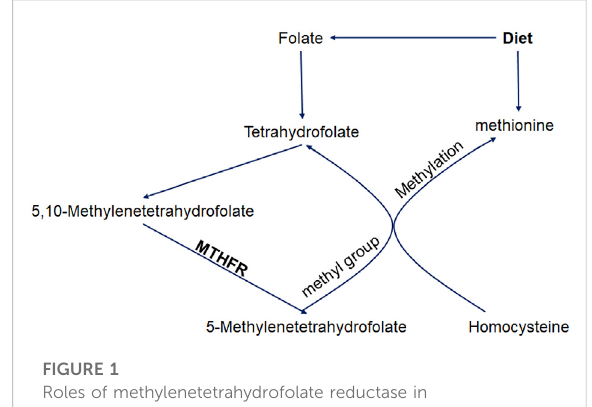
FIGURE 1 Roles of methylenetetrahydrofolate reductase in homocysteine